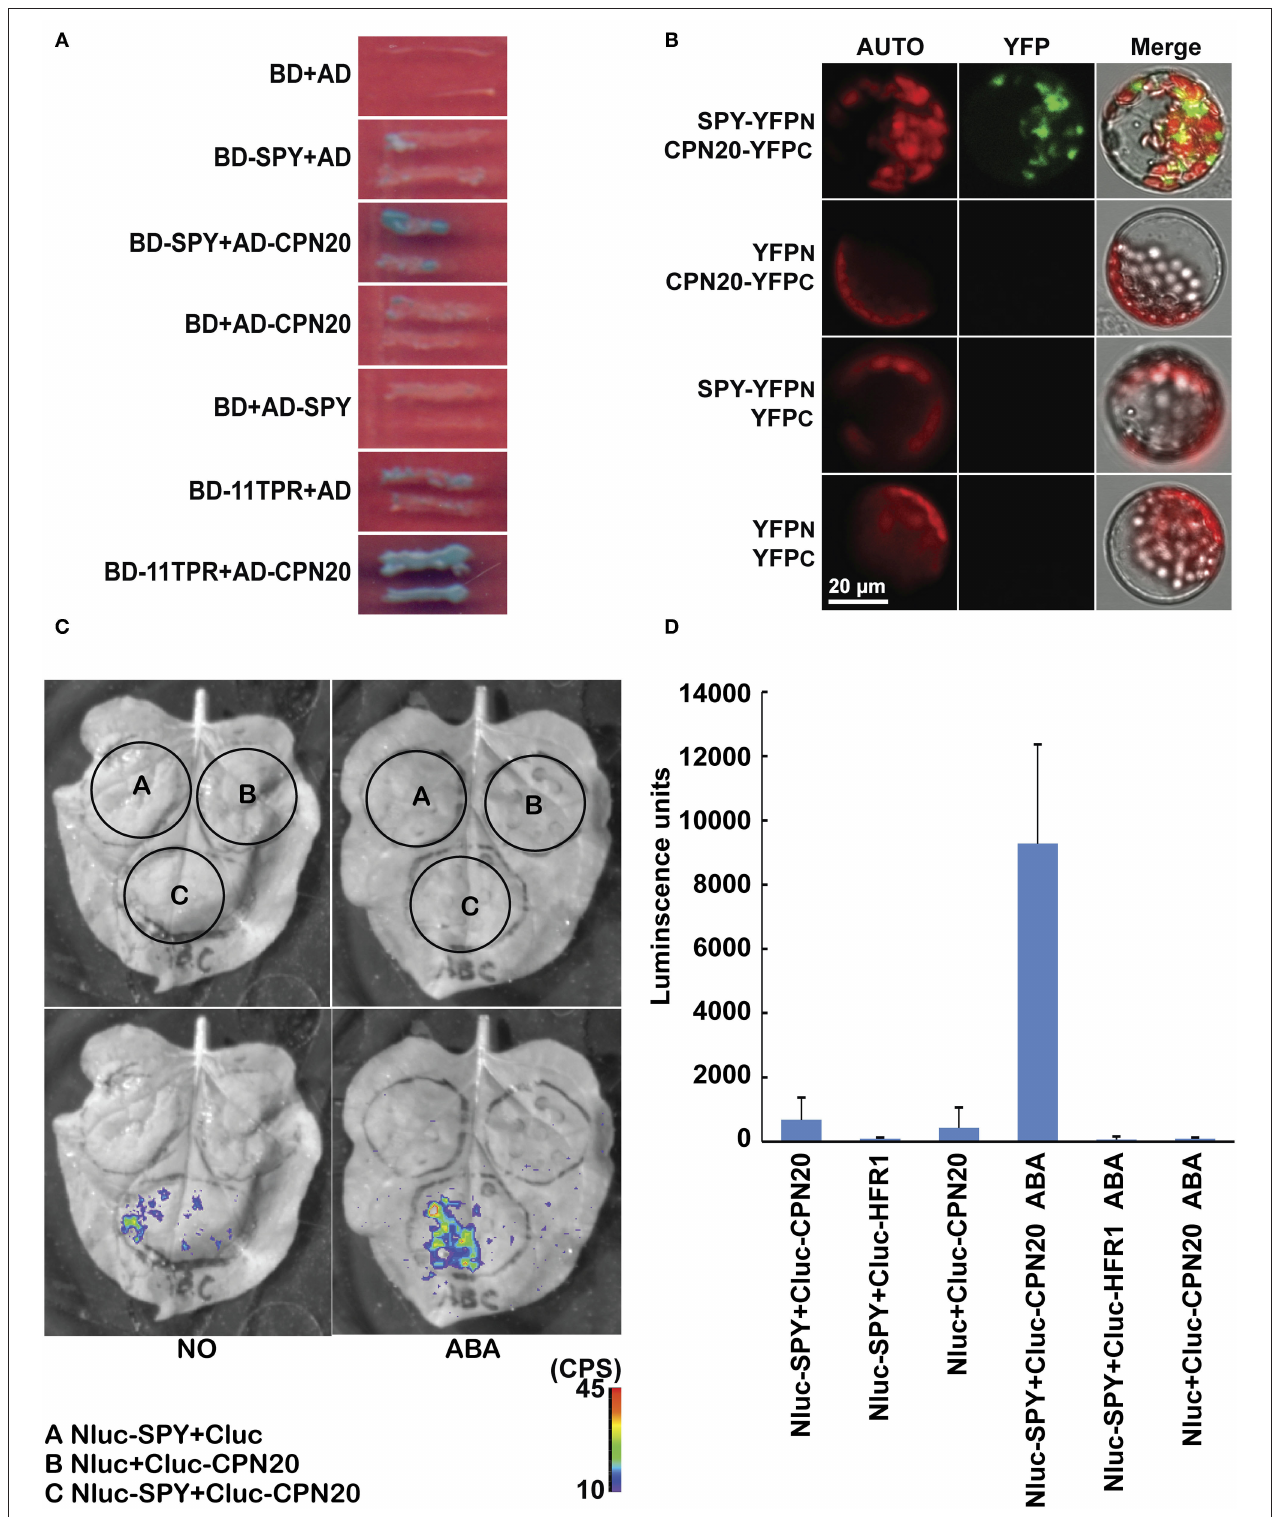
FIGURE 1 | SPY interacts with CPN20. (A) SPY interacts with CPN20 through TPR domains in yeast two-hybrid assay. Pictures were taken after yeast cells were grown on SD-3/X/A for 4 days. BD, DNA-binding domain; AD, activation domain; SD-3/X/A, SD medium lacking Leu, Trp, and His and adding X- α -Gal